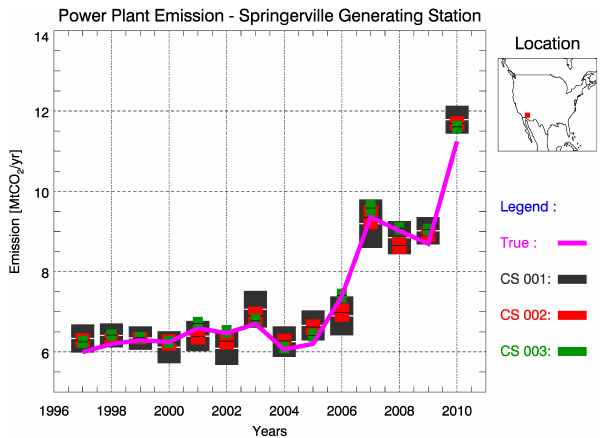
Fig. 11. Reported annual emissions from the Springerville generat- ing station in Arizona, USA (1997–2010). The yearly (true) emis- sions are denoted by the magenta line. The simulated measurements from three different CarbonSat constellation configurations are rep- resented by the bars (color-coded). The height of the bars represent the random errors for the annual emission